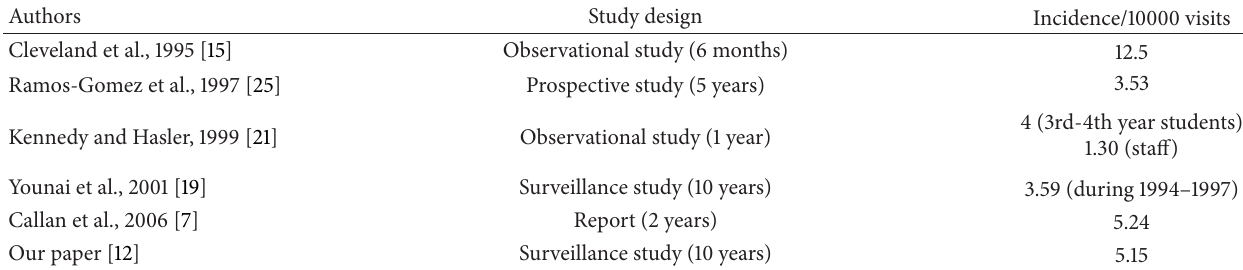
Table 2: Incidence of accidents in the school of